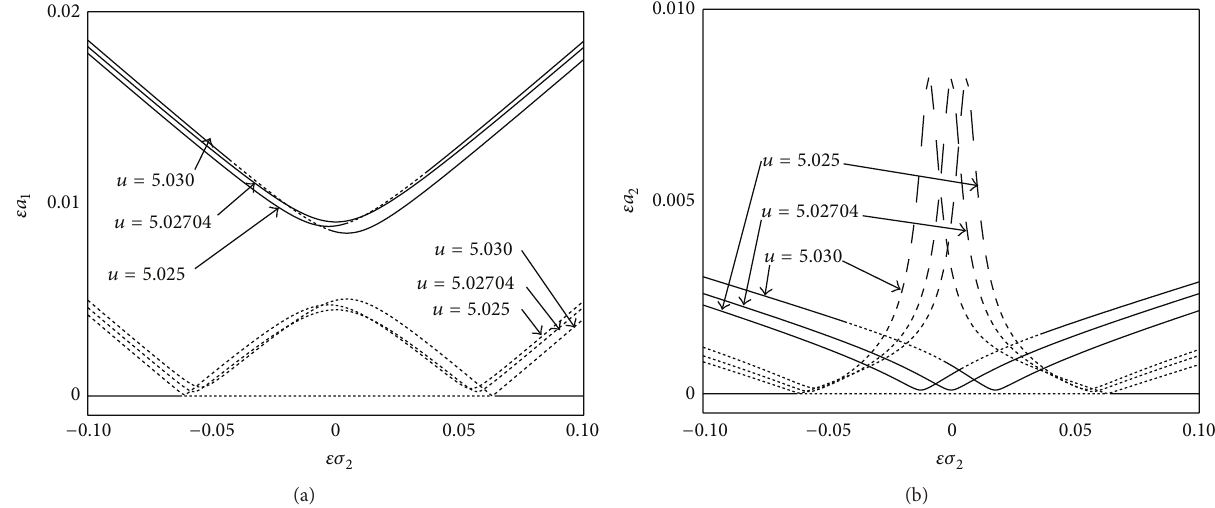
Figure 13: Amplitude-frequency curves of the summation resonance for different flow speeds: (a) the first mode and (b) the second mode.